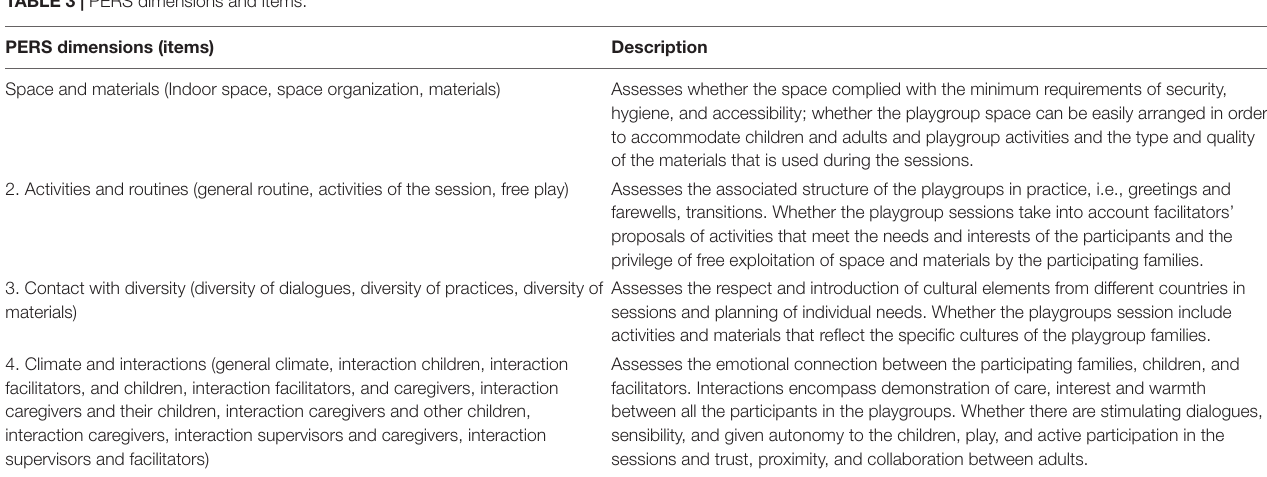
TABLE 3 | PERS dimensions and